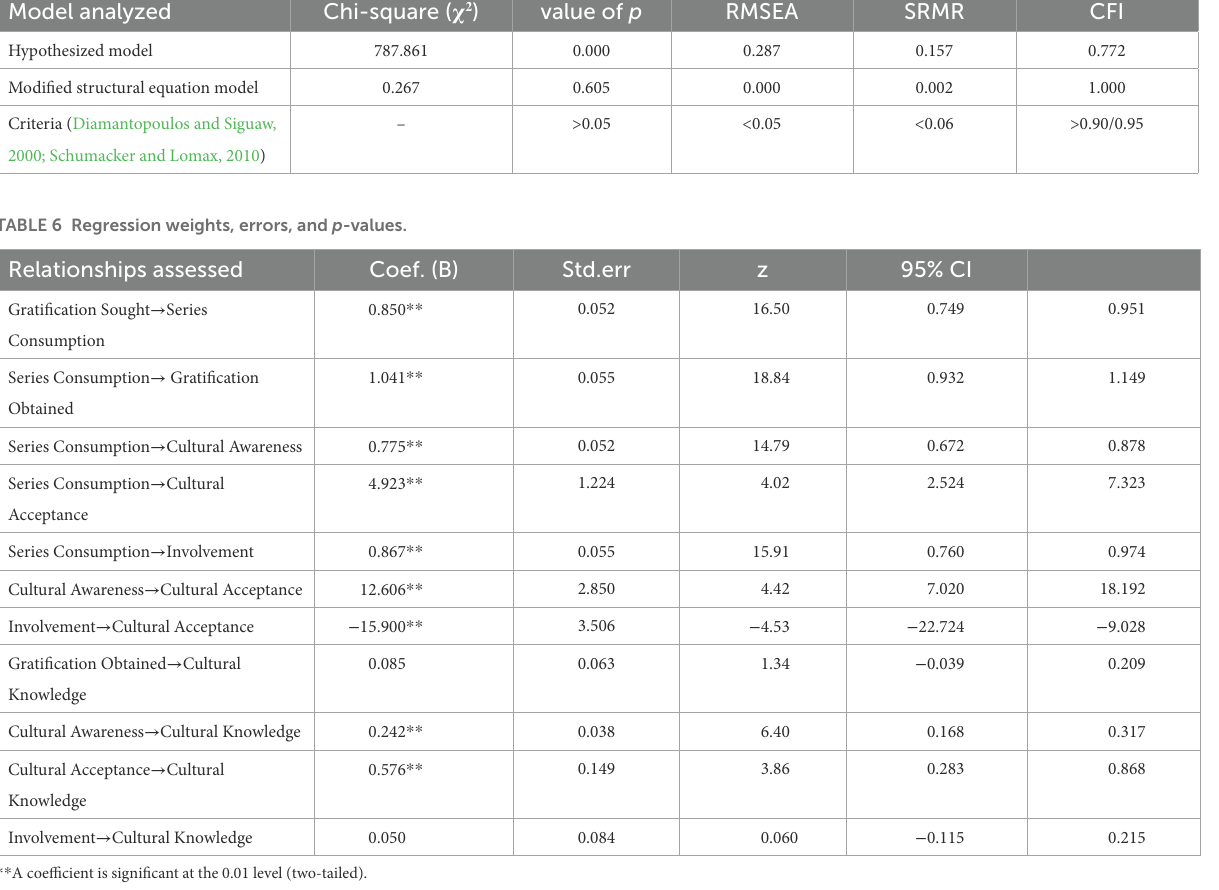
TABLE 5 Degree of Model Fitness Statistics. Model analyzed